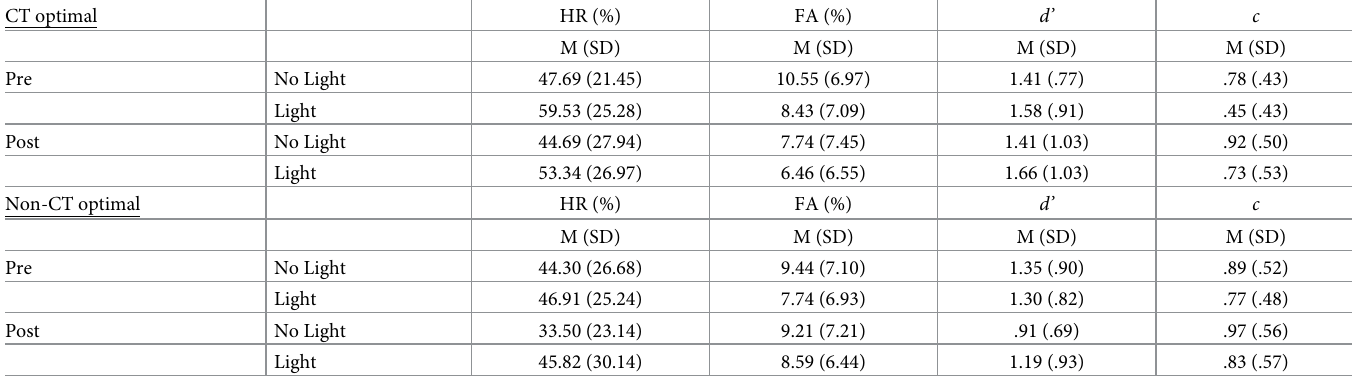
Table 2. Descriptive statistics for hit rate, false alarm rate, d’ and c in each Light (Light and No Light) and Time (Pre and Post) condition during the SSDT, in each group (CT and non-CT). CT optimal